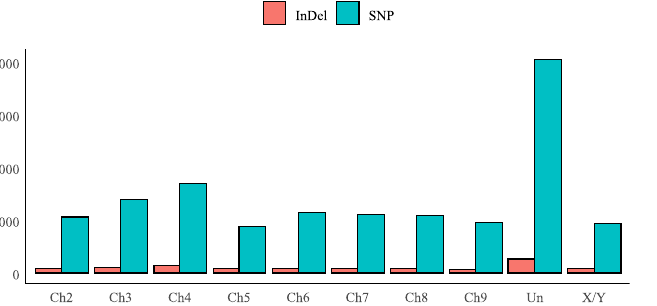
Figure 1. SNP and InDel distribution across the papaya chromosomes. Ch chromosome, Un unmapped contigs and scaffolds, X/Y sexual chromosomes